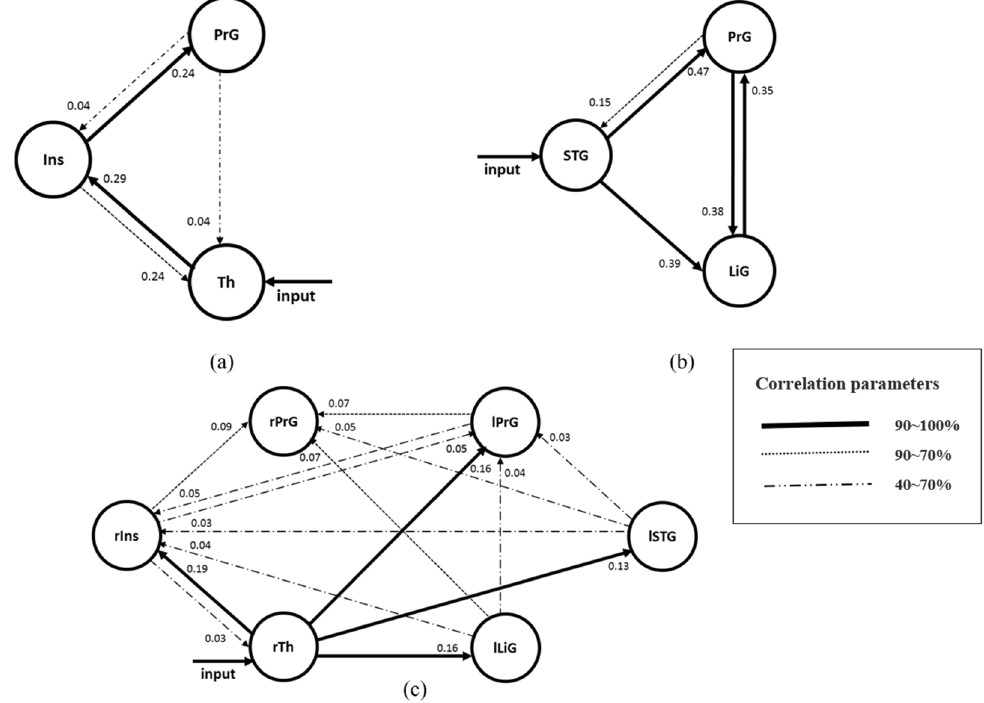
Figure 4. The model for the effective connectivity of the regions in the ( a ) right hemisphere, ( b ) left hemisphere, and ( c ) the entire brain while performing a secondary task and driving. Table 1. Correlations of the three regions in each of the right and left hemispheres while perform- ing a secondary task while driving.